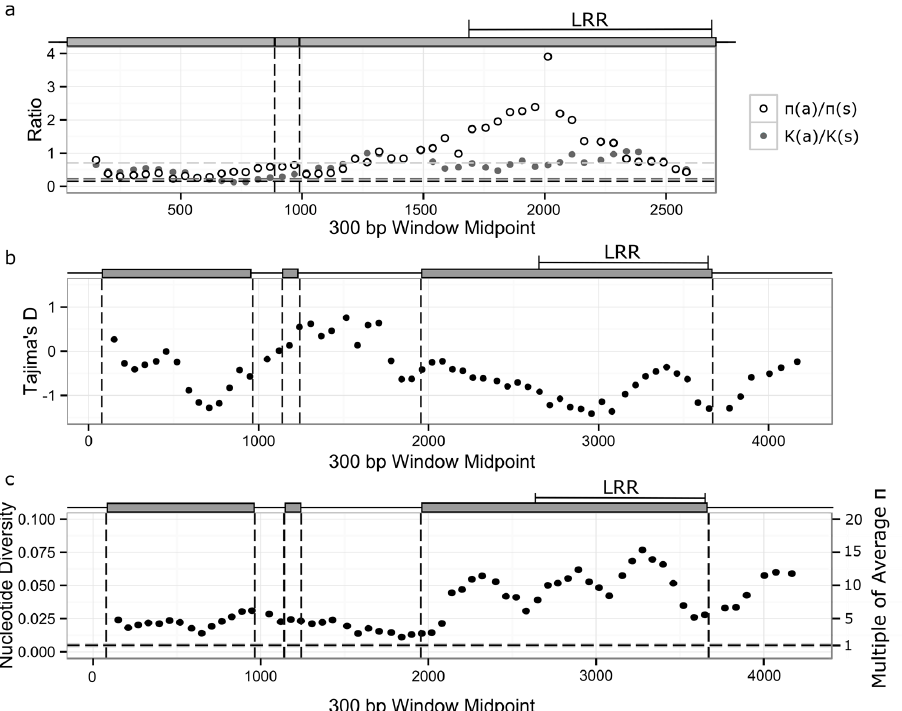
Figure 3. Sliding windows of within-species polymorphism and divergence between Arabidopsis thaliana and A. lyrata for paralog P1 at RPP8 . Plots for paralogs P2 and P3 can be found in Figures S10–S12. Grey boxes above the plots represent positions of exons of P1. Vertical lines indicate exon boundaries, as shown in the schematic above each plot. The leucine-rich repeat region (LRR) is also indicated. ( a ) π a : π s and K a :K s within A. thaliana and between A. thaliana and A. lyrata. Black and dark grey dashed horizontal lines indicate average levels of π a : π s and K a :K s within A. thaliana and between A. thaliana and A. lyrata ; light grey dashed line is the 95% right-hand tail for K a :K s . ( b ) Tajima’s D. ( c ) Synonymous nucleotide diversity. The black horizontal dashed line indicates the average level of nucleotide diversity within A. thaliana ; the line width is the confidence interval for average nucleotide diversity.